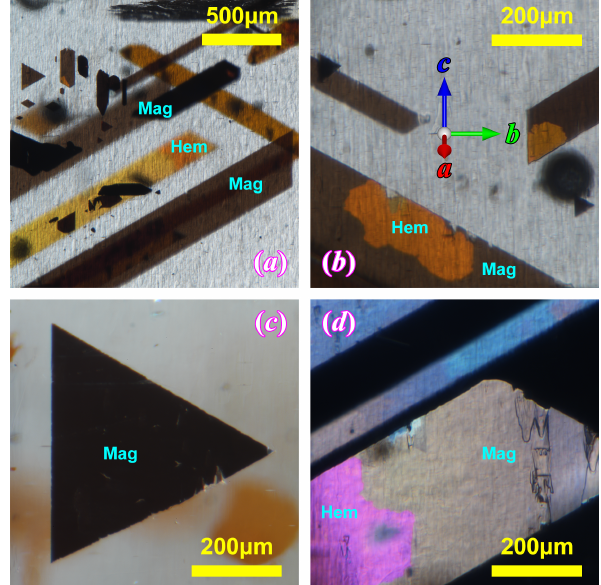
Figure 4. The thin film iron oxide inclusions in the RLS under op- tical microscope. All the images are taken with the same orienta- tion of the orthoclase as labeled in (b) . Panels (a) , (b) and (c) are bright-field-transmission illuminated, and (d) is taken under reflec- tive lighting. Magnetite appears black or dark brown, and hematite appears light yellow to deep orange in transmission light (a–c) . The pink color in the bottom left corner of (d) is the interference color of a hematite patch in a magnetite-dominated film, similar to the one shown in (b) . The blueish color of the narrower inclusion in (d) is tarnishing on a magnetite film, which is also common in the